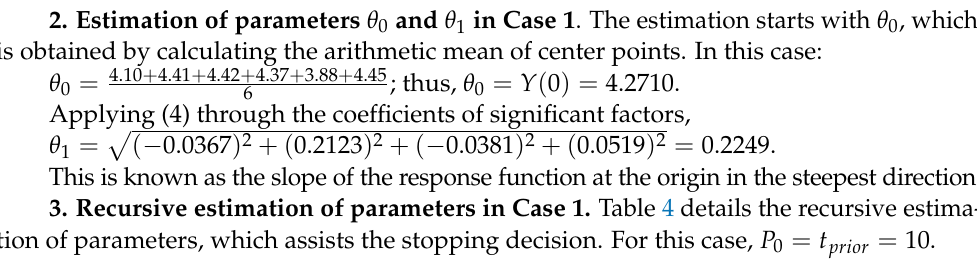
Figure 4. Graph with the steepest ascent path of the response y with a curved line, which assumes quadratic behavior in Case